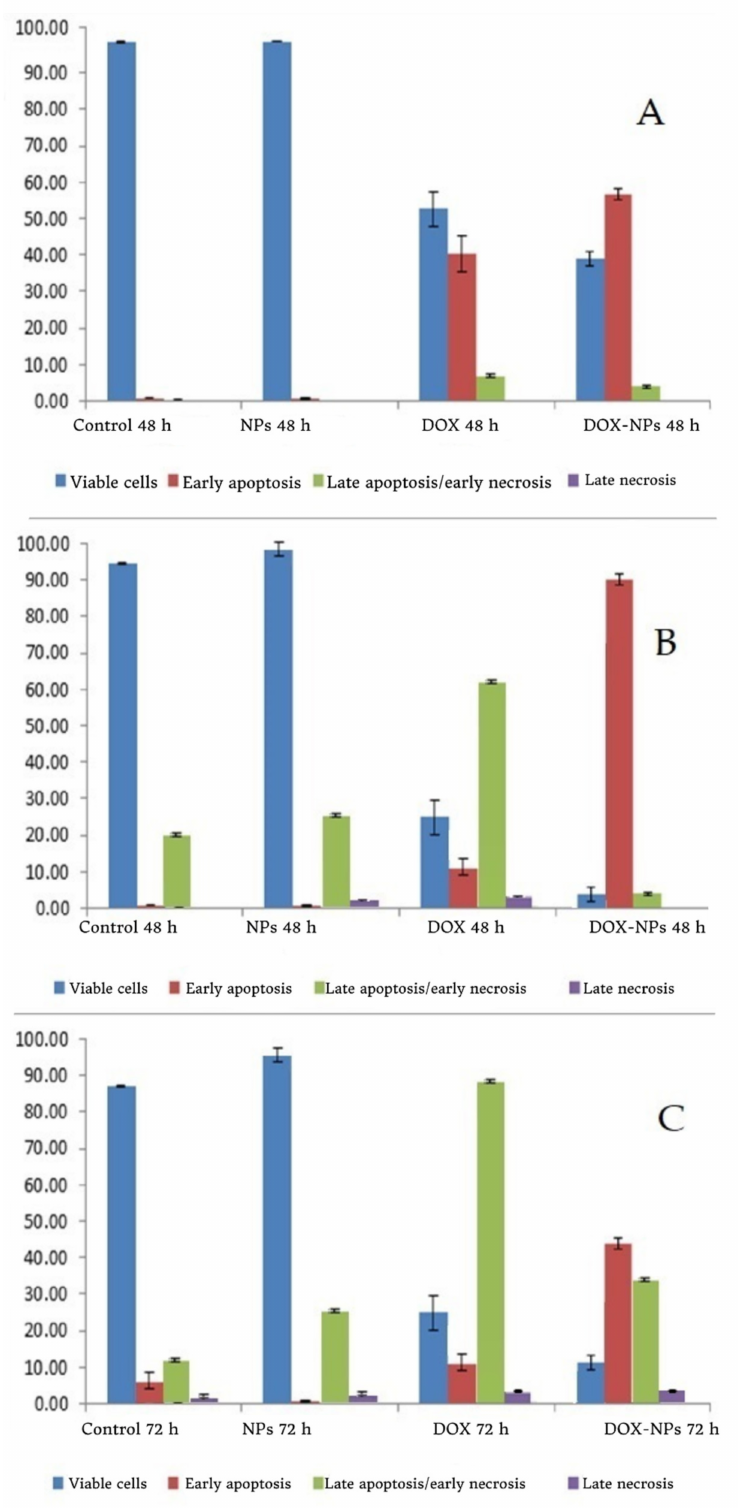
Figure 4. The flow cytometry histograms. ( A ) 24 h of treatment with the control, AR-CC-NPS, DOX, and DOX-Ar-CC-NPs groups. ( B ) 48 h of treatment, with the control, AR-CC-NPS, DOX, and DOX-Ar-CC-NPs groups. ( C ) 72 h of treatment with the control, AR-CC-NPS, DOX, and DOX-Ar- CC-NPs